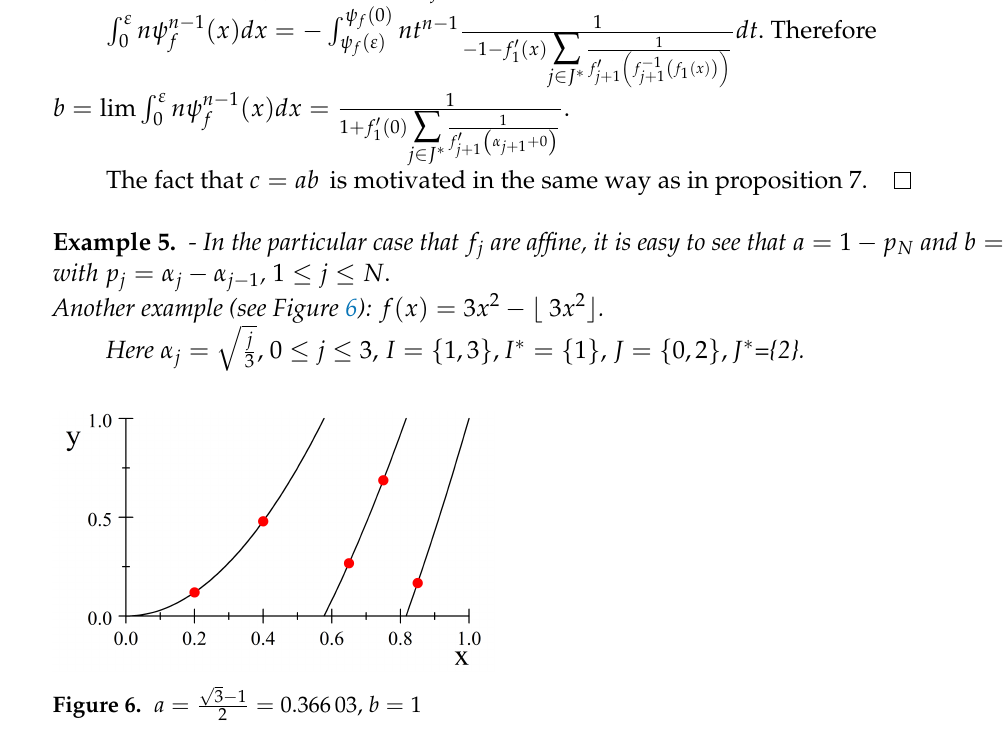
√ 3 − 1 = 0.36603, b = 2